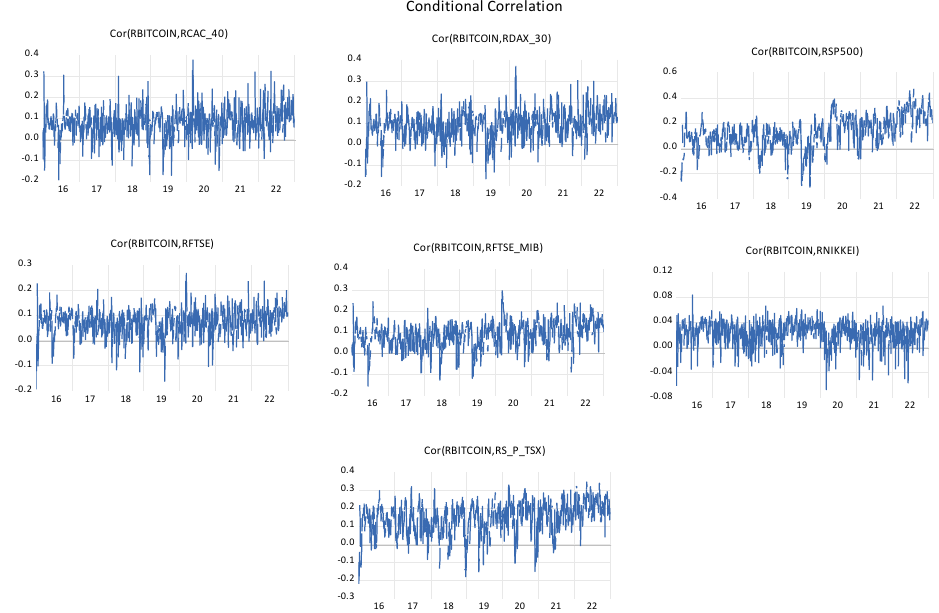
Figure A1. Dynamic conditional correlation evolution between Bitcoin and each of the G7 stock market indices. Table A2. D-VECH model results (GOLD-G7 indices).